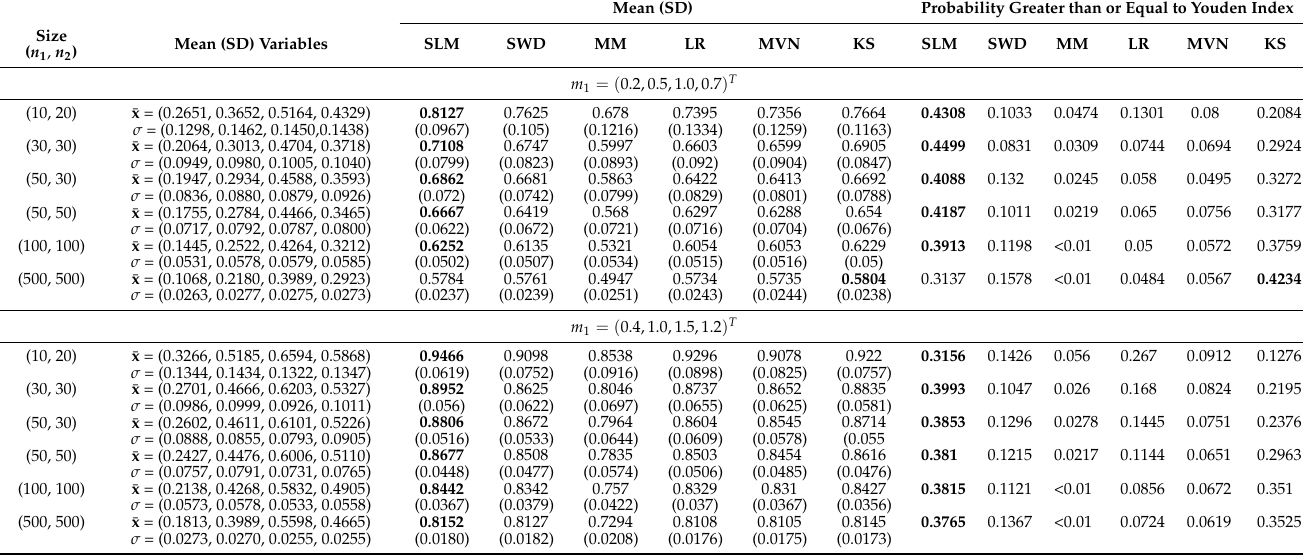
Table 6. Normal distributions: Different means. Negative correlation ( − 0.1). Mean (SD) Probability Greater than or Equal to Youden